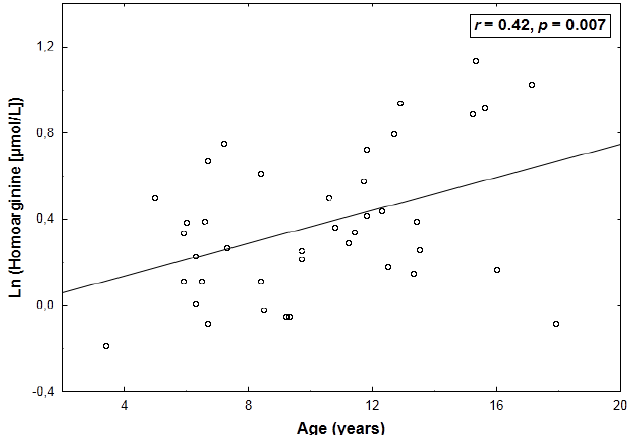
Figure 1. A positive correlation between age and natural logarithmically (ln)-transformed plasma levels of homoarginine.